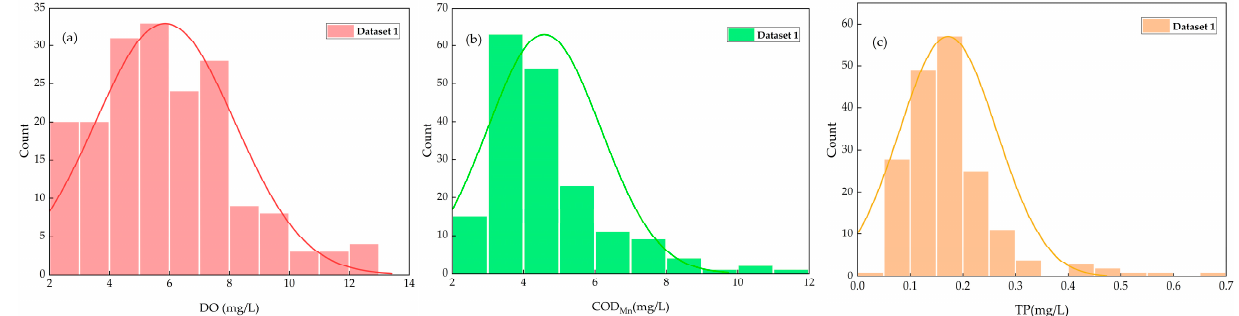
Figure 3. Distributions of Dataset 1’s DO ( a ), COD Mn ( b ), and TP ( c ).